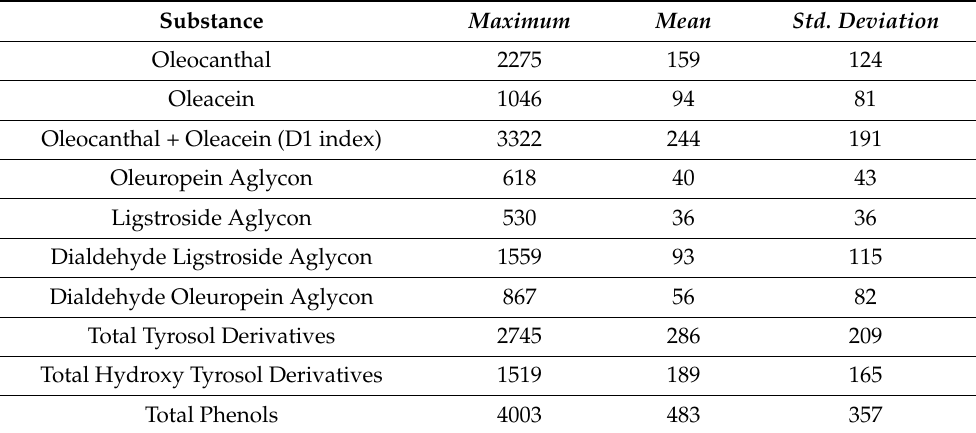
Table 1. The maximum and mean concentrations (mg/kg) of the studied substances for the Greek analyzed samples ( n = 5764).